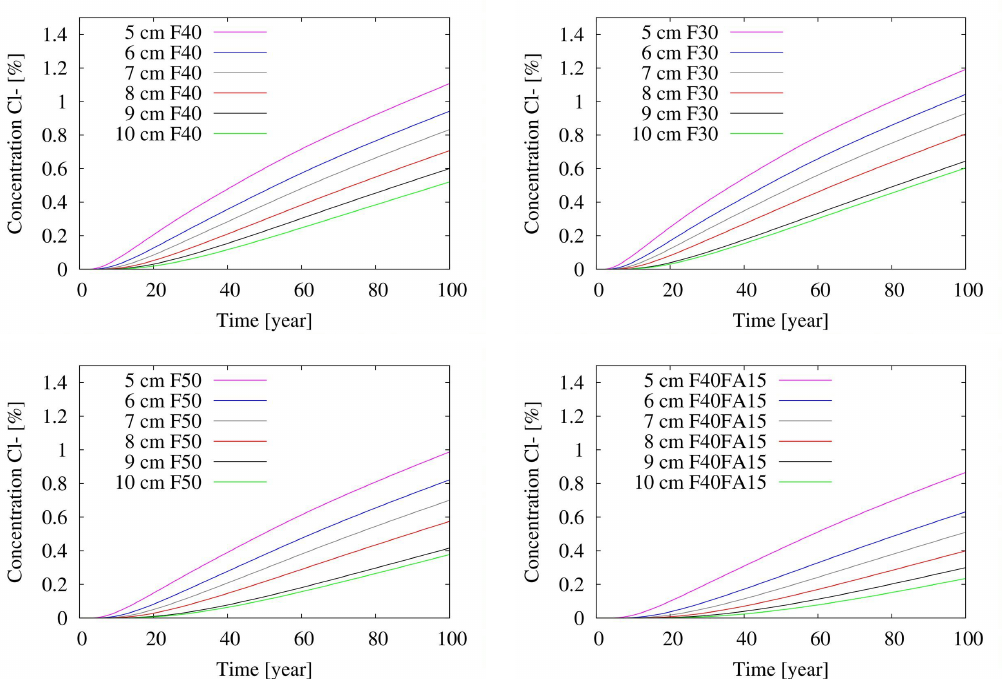
Fig. 9. Evolution of chloride concentration with four concrete samples